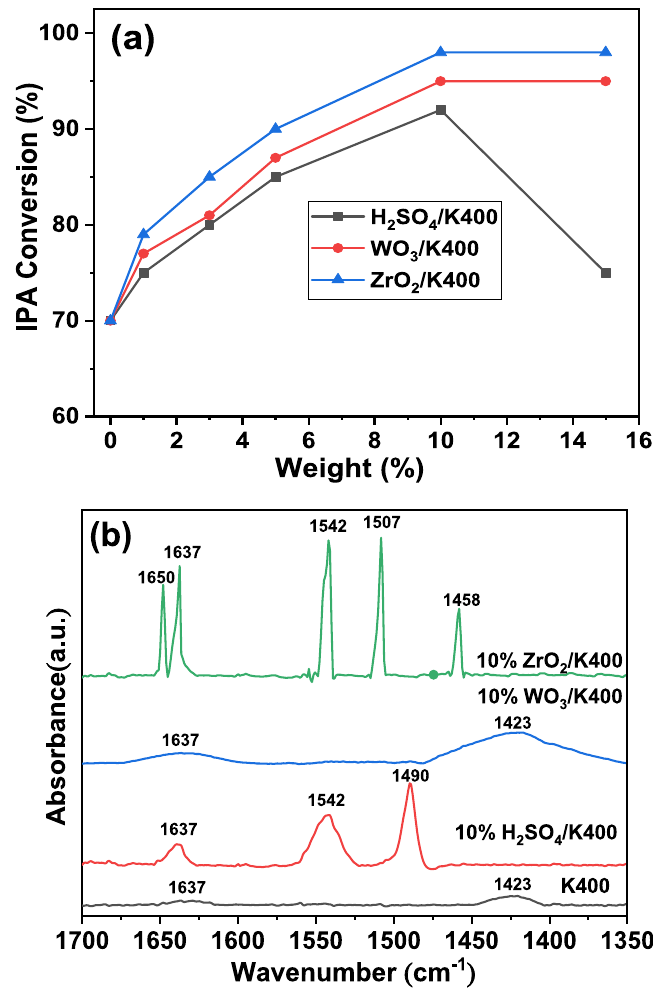
Figure 5. Catalytic dehydration of IPA over ( a ) kaolin and modified kaolin catalysts, and ( b ) FTIR spectra of pyridine adsorption on kaolin and modified kaolin catalysts calcined at 400 °C. Error bar =